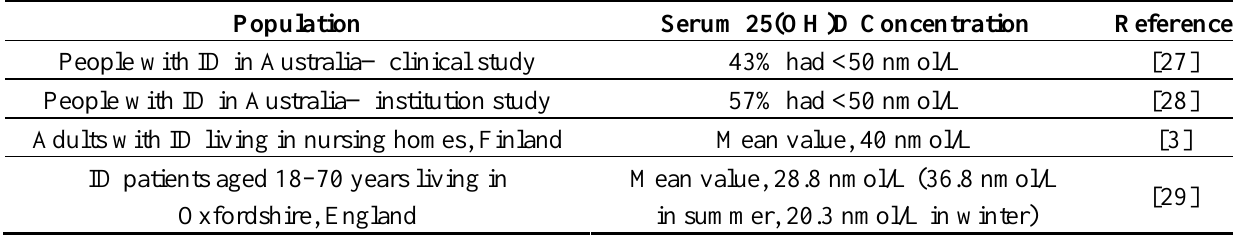
Table 3. Blood 25(OH)D concentrations among those with